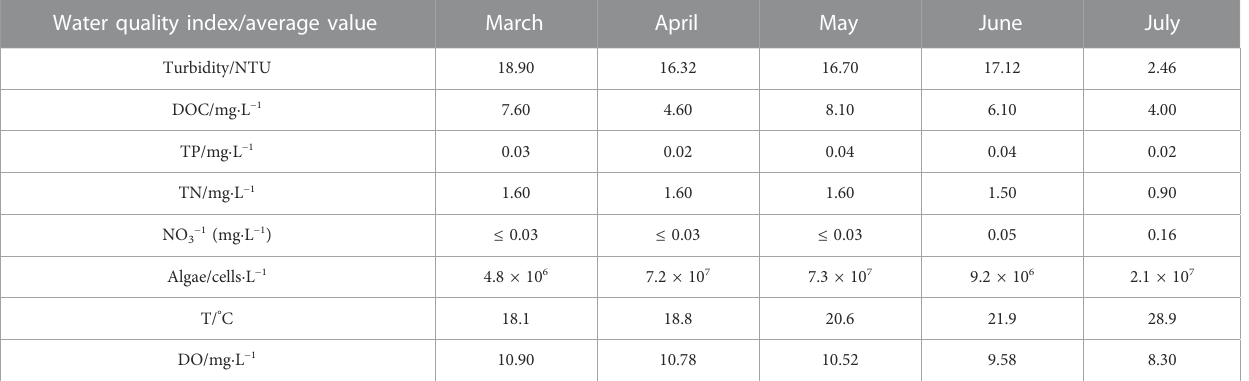
TABLE 1 Water quality parameters of raw water in